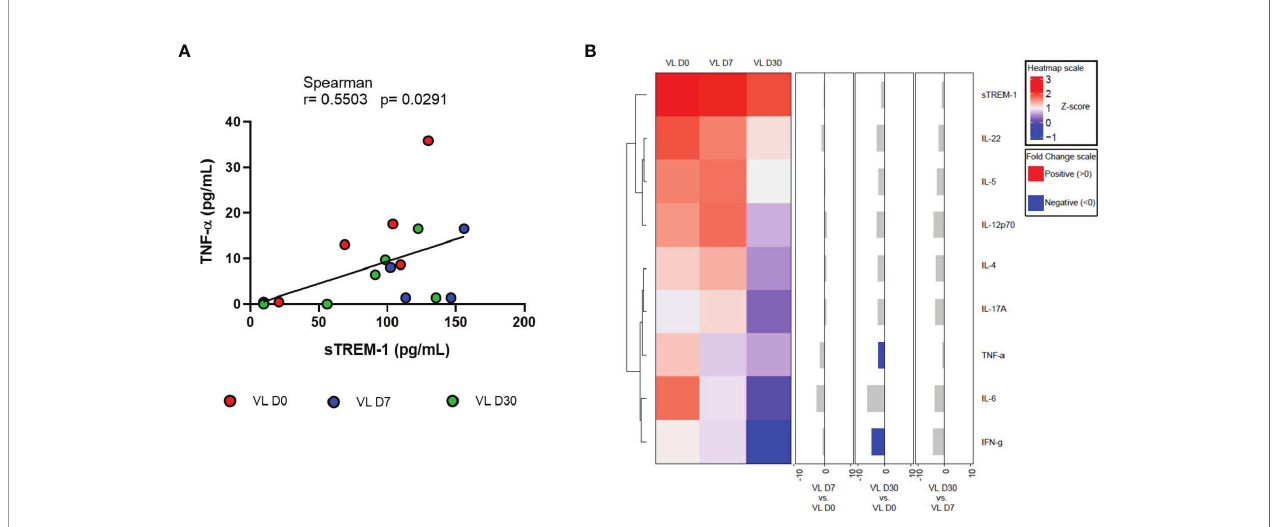
FIGURE 3 | (A) Correlation between sTREM-1 with TNF-a serum levels from patients with VL at different times of leishmanicidal treatment. Spearman correlation test. (B) Cluster analysis and heatmap expressing serum in fl ammatory mediators in VL patients at different times of leishmanicidal treatment. Fold changes have been calculated, and signi fi cant differences are highlighted in